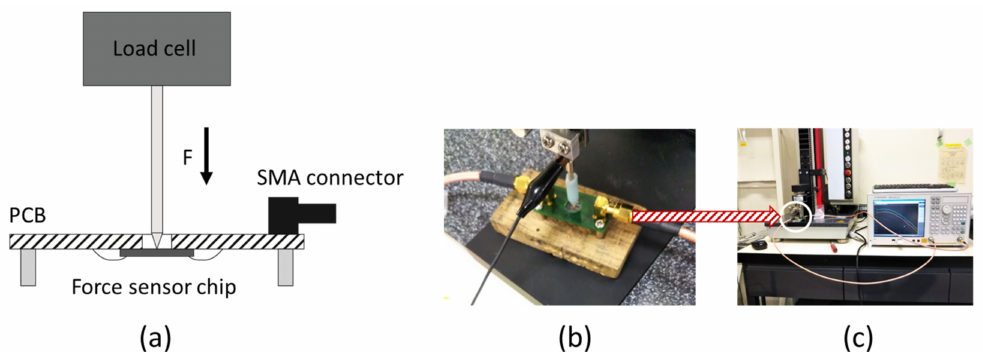
Figure 6. ( a ) Schematic characterization setup for the force sensor. ( b ) Picture of the PCB in the mea- surement setup. ( c ) Picture of the whole measurement setup, including the connected network analyzer. To obtain the impedance of the force sensor, the S11 parameter in shunt configu- ration was determined by the network analyzer during the quasi-static application of defined force values. The S11 parameter results were converted into impedance values. S parameter measurements are a method of determining the behavior of circuits at high frequencies